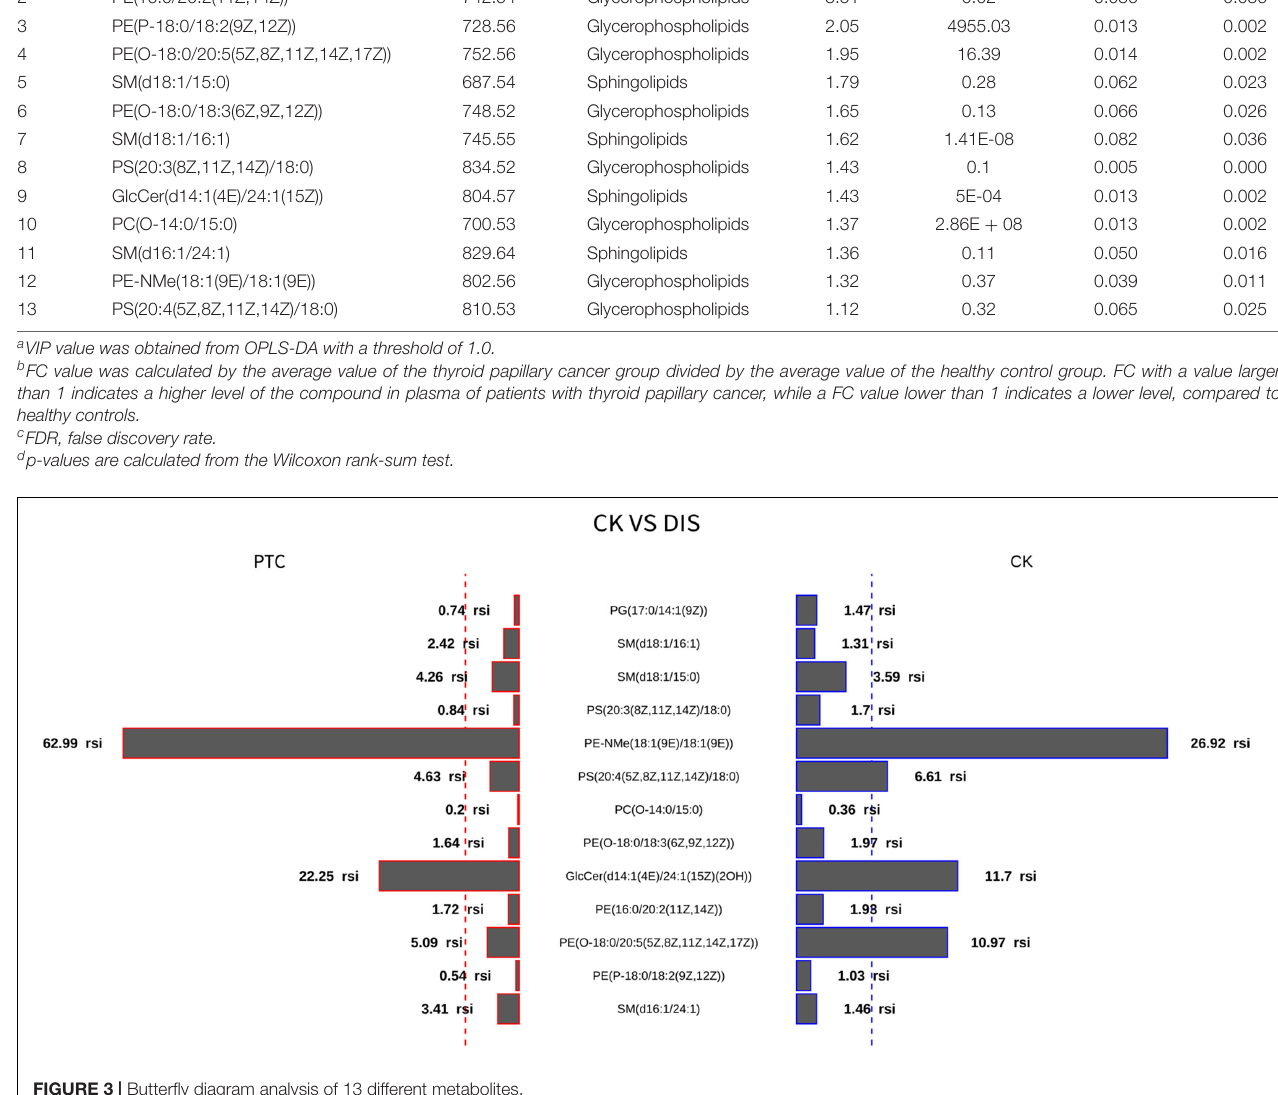
FIGURE 3 | Butterfly diagram analysis of 13 different